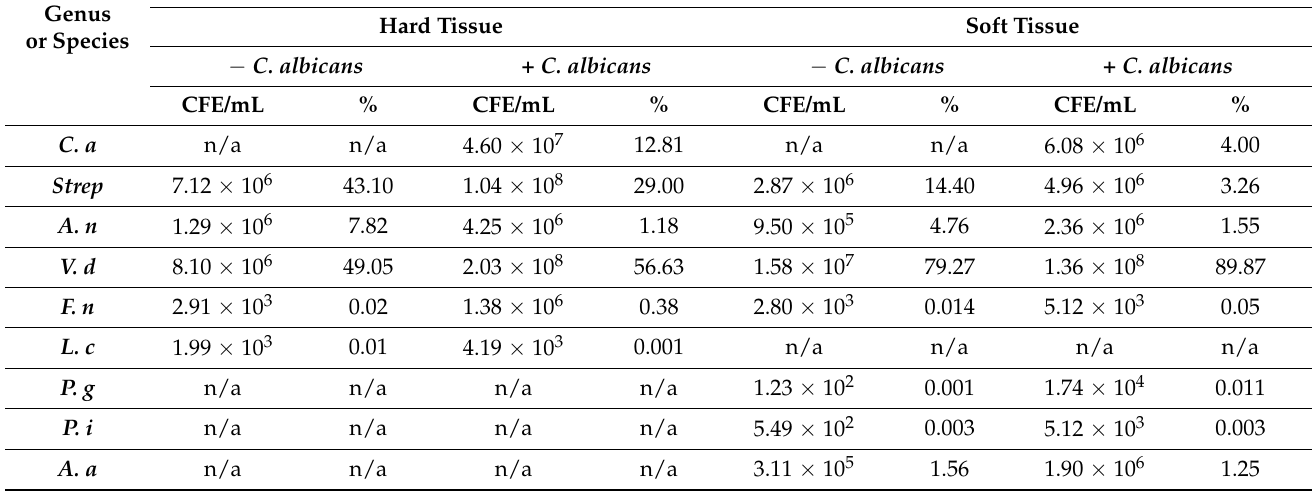
Table 2. Mean colony forming equivalent per mL and average percentage composition for each genus or species in the hard and soft tissue biofilms. CFE/mL and percentage composition shown for each genus or species as an average of 9 independent biofilms (n = 3 from 3 separate experiments). All numbers shown in the table have been rounded to the first significant decimal place, where